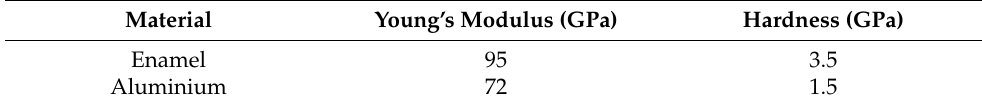
Table 2. Comparison of hardness and Young’s modulus for enamel and aluminium [20].